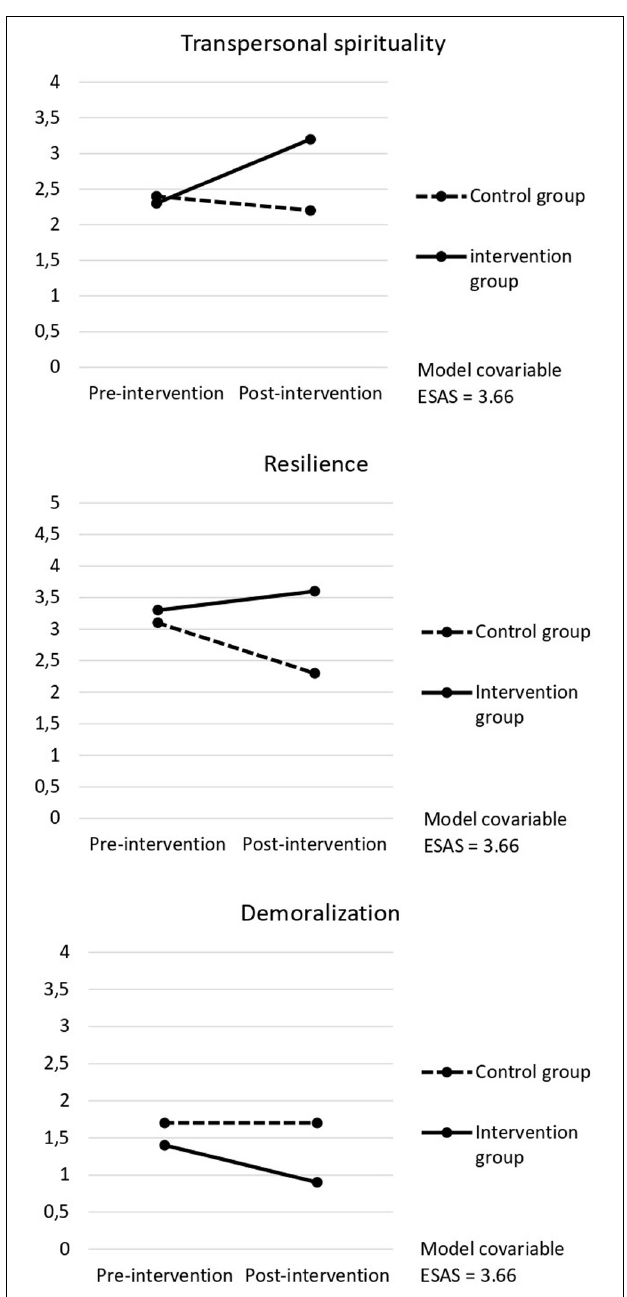
FIGURE 2 | Estimated pre- and post-intervention marginal means for the intervention and control groups, for the variables with a statistically significant interaction effect.